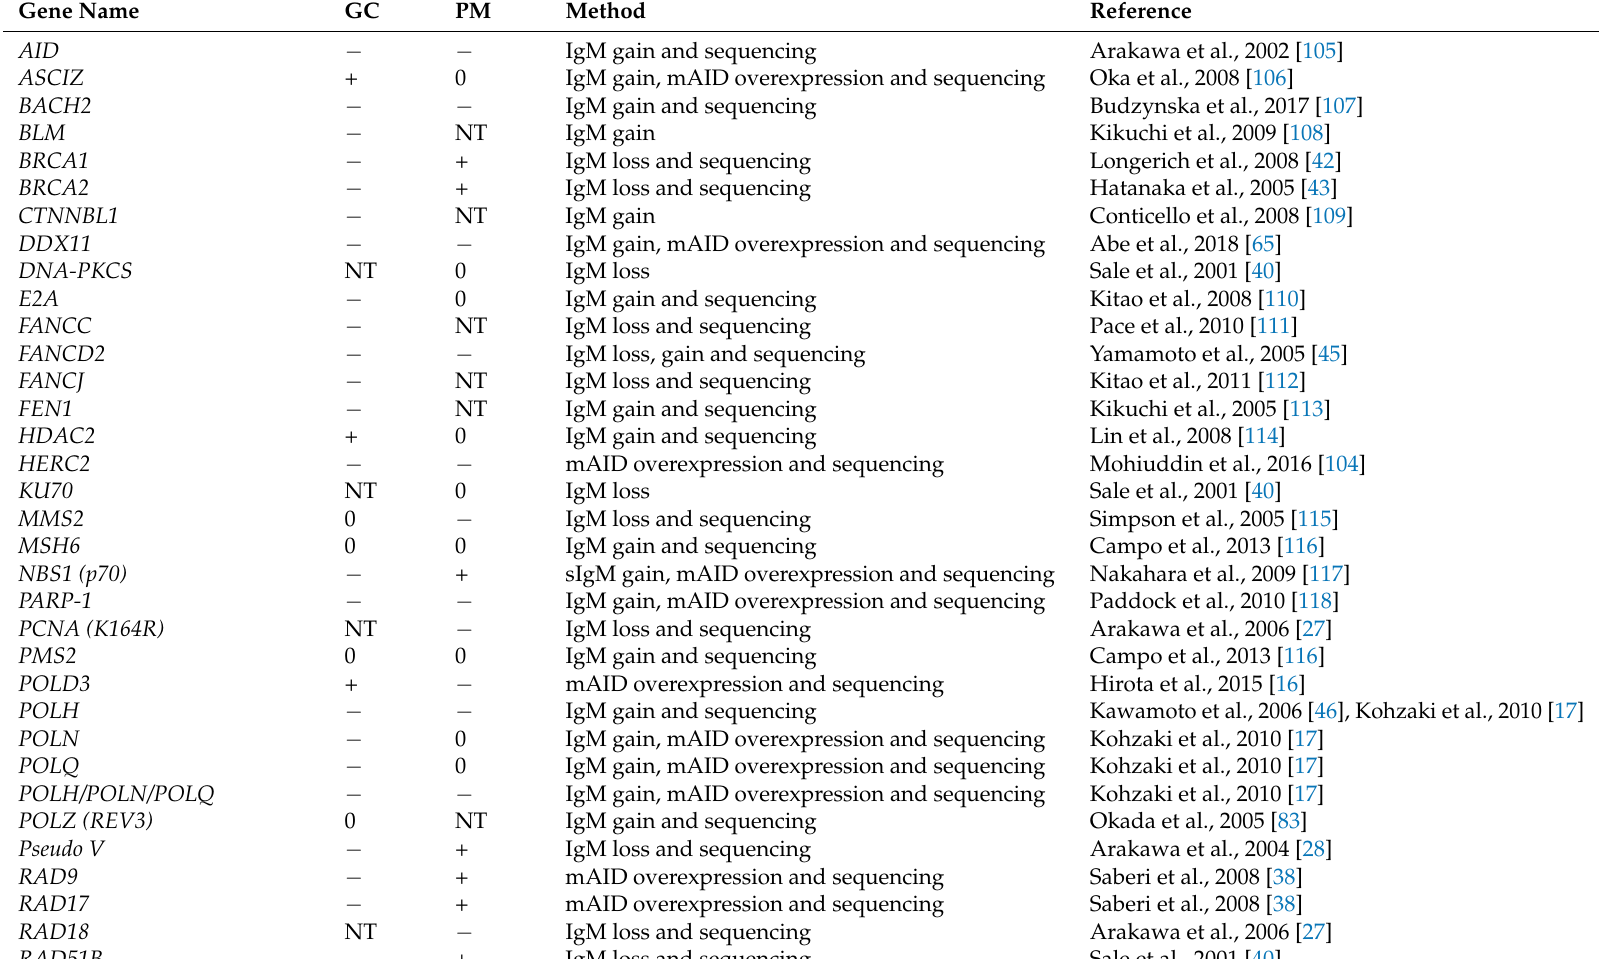
Table 1. Genes involved in Ig gene conversion and